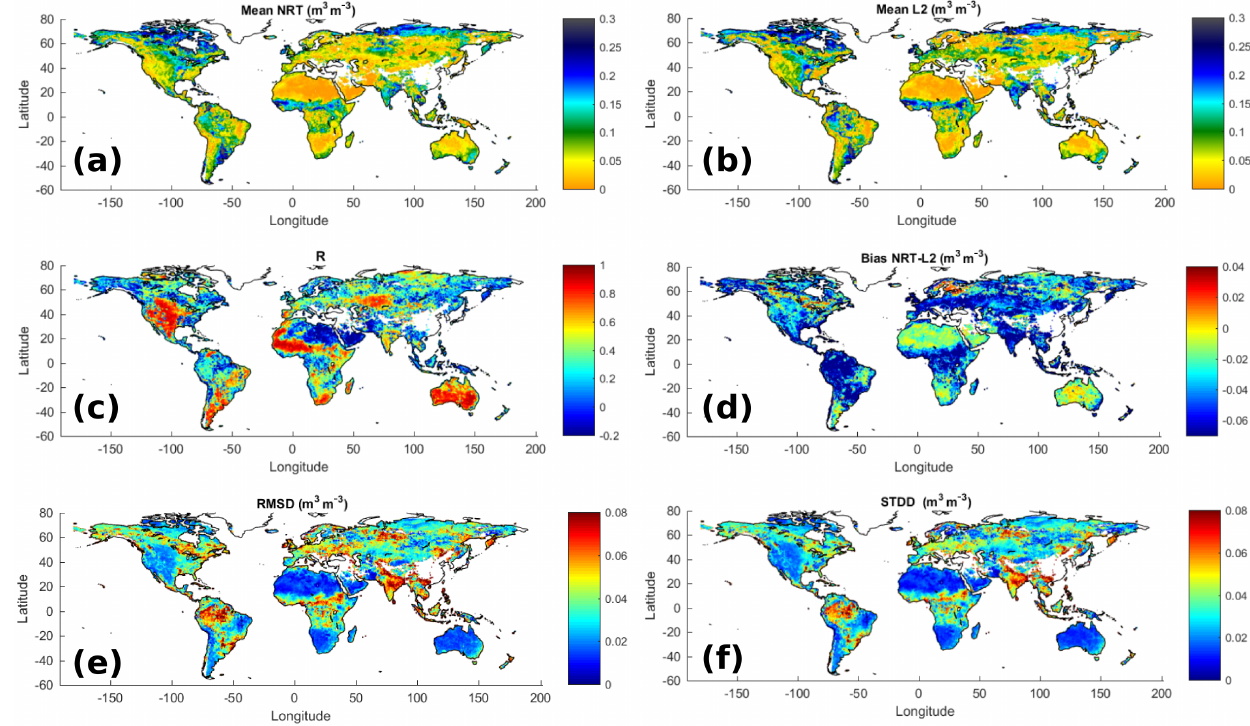
Figure 3. Mean SM for the NRT (a) and the L2 (b) SMOS products. Pearson correlation (c) , bias (d) , root mean square of the difference (e) and standard deviation of the difference (f) of the NRT SM and L2